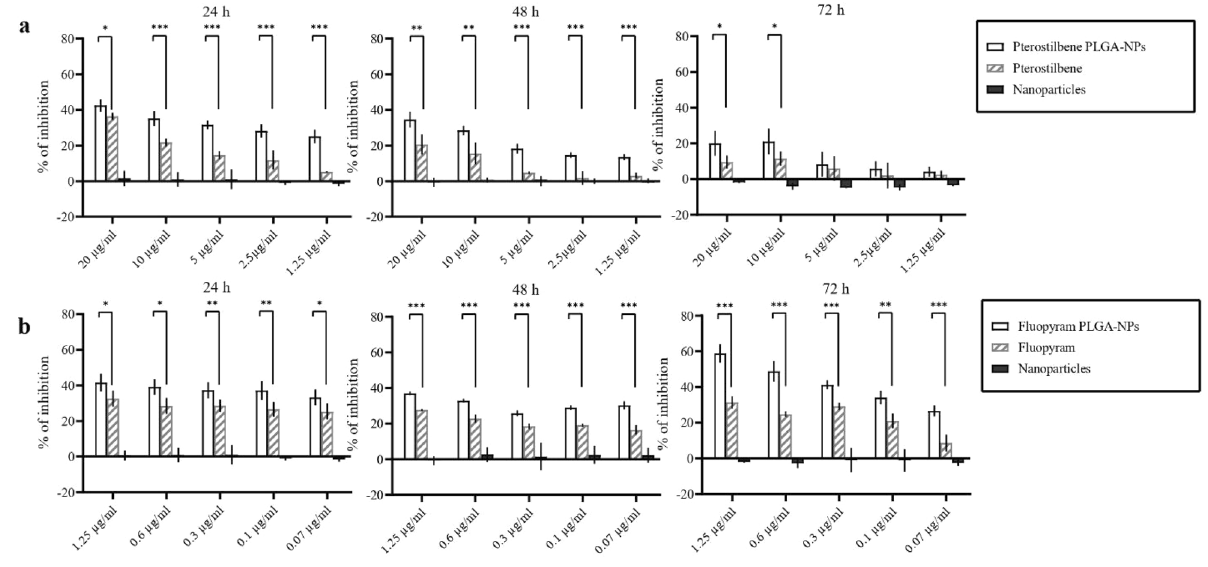
Figure 4. Activity of pterostilbene and fluopyram, free or loaded in PLGA NPs, against non-germinated conidia of Botrytis cinerea DSM 877 after 24, 48, and 72 h of incubation. * P ˂ 0.05, ** P ˂ 0.01, *** P ˂ 0.001.